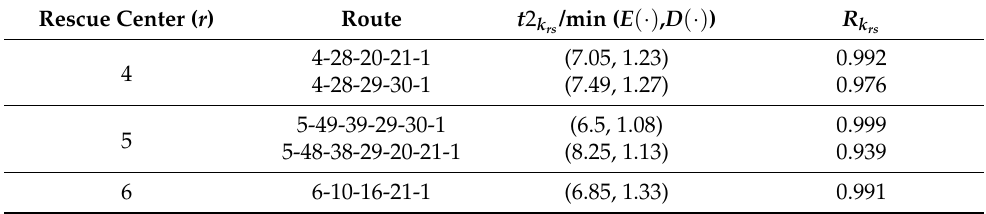
Table 10. Feasible routes and their reliability for rescue resource